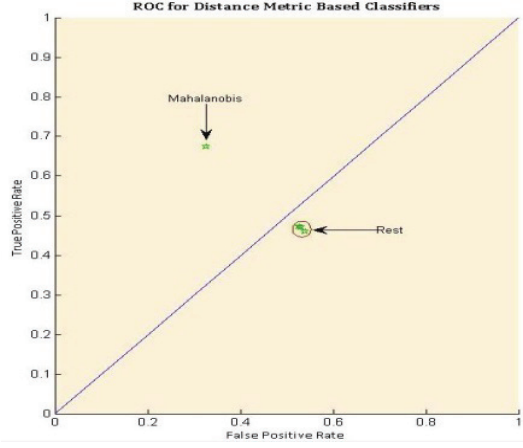
Fig. 17. ROC space for distance based Classifier